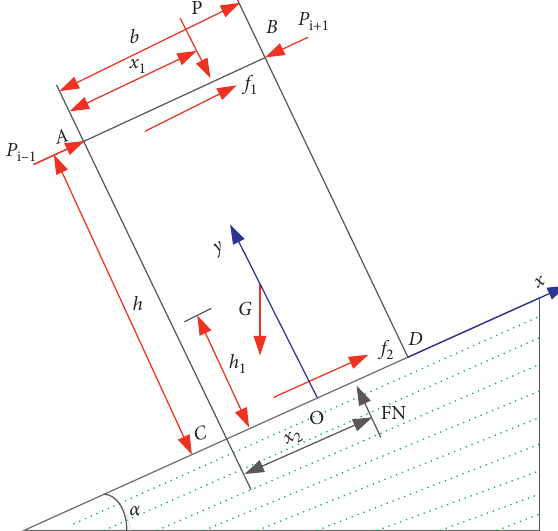
Figure 10: Mechanical model of a single inclined support.